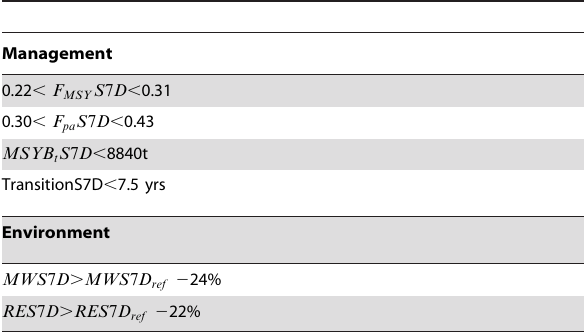
Table 7. Results of the classification performed with conditional trees for sole.